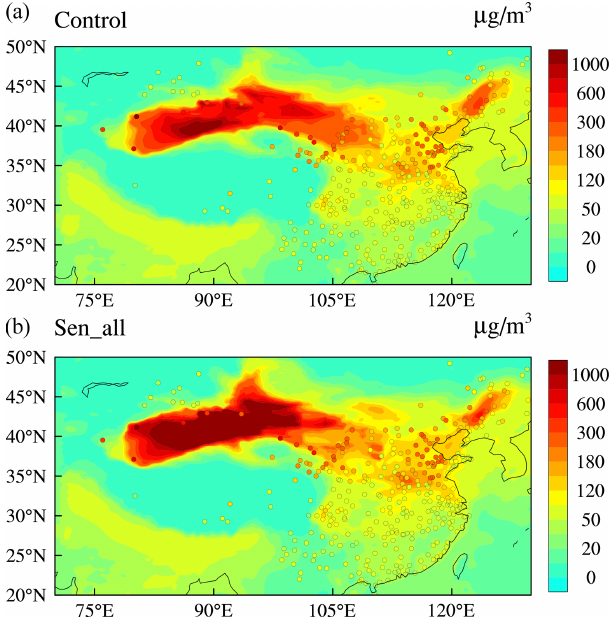
Figure 11. Comparison of simulated averaged PM 10 surface con- centrations from the control run (a) and Sen_all (b) with the ob- served